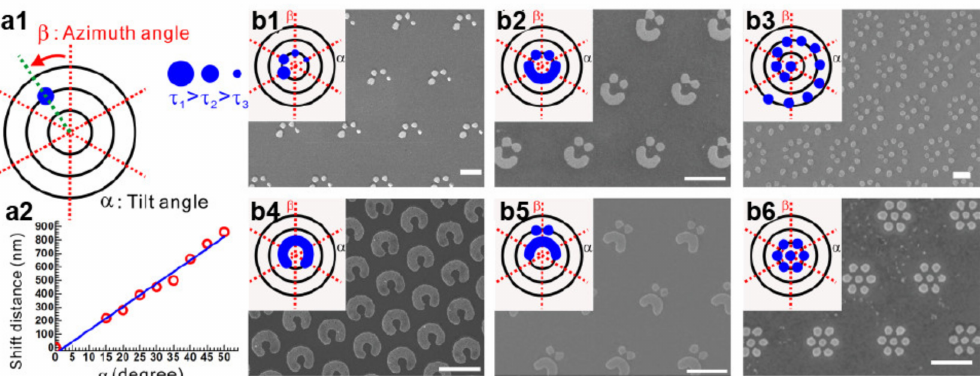
Figure 4. Nanojet lithography under oblique illumination ( a1 ) Polar chart depicting three controllable variables ( α , β , τ ) for arbitrary nanopatterning. ( a2 ) Linear relationship between the tilt angle ( α ) and shift distance of the focal position. ( b1 – b6 ) Examples of designed and generated periodic nanopatterns. Scale bars 1 µ m. Adapted with permission from [73] Copyright 2017 American Chemical